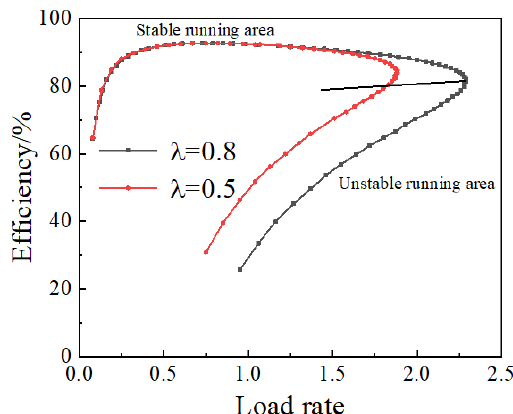
Figure 23. Efficiency curves.